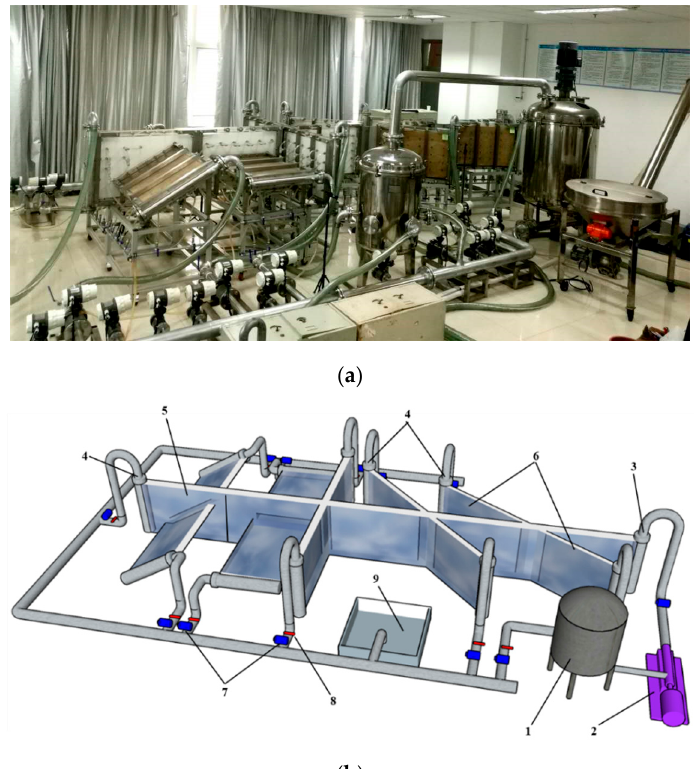
Figure 1. Experimental apparatus, ( a ) photogragh of the real setup, ( b ) schematic of the experimental apparatus (to scale), (1) blender, (2) progressive cavity pump, (3) inlet, (4) outlets, (5) primary fracture, (6) secondary fractures, (7) magnetic flow meter, (8) valve, (9) sedimentation